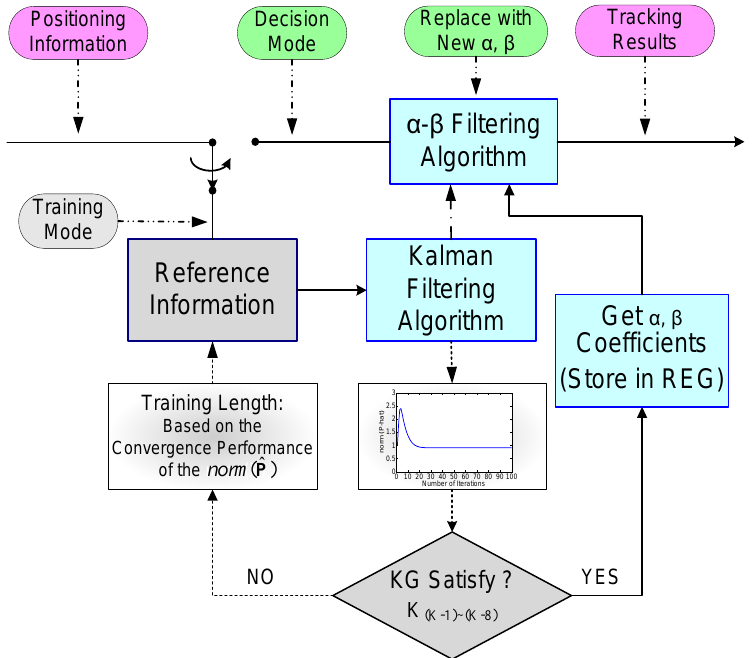
Figure 2. Flow diagram of α - β filtering algorithm.